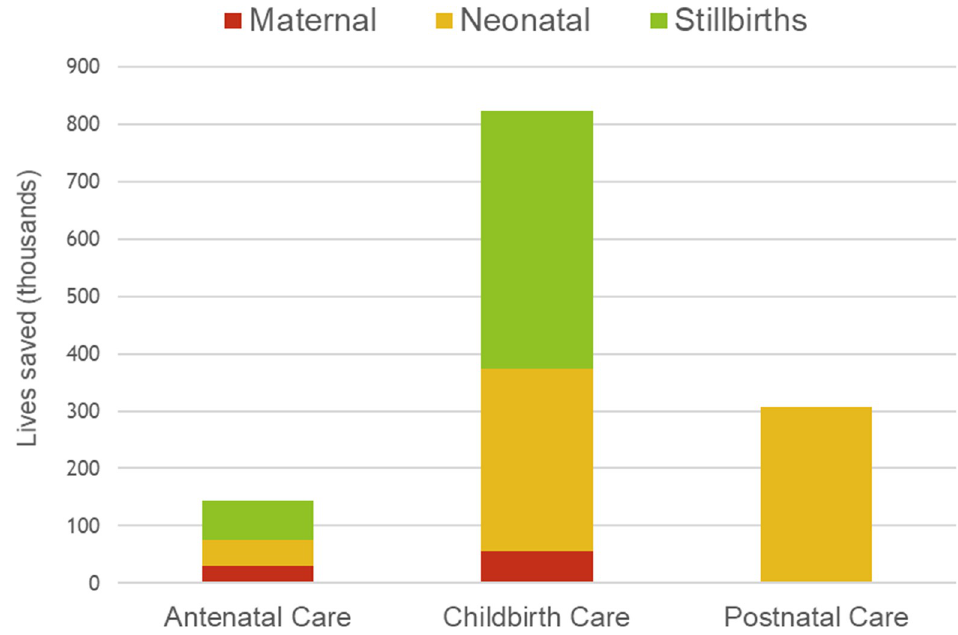
Fig 3. Bar graph of estimated impact in 81 LMICs, with 2020 as the target year. The total number of maternal (tan) and neonatal (orange) lives saved and stillbirths prevented (green) organized by the timing of delivery for the evidence-based intervention. LMIC, low- and middle-income